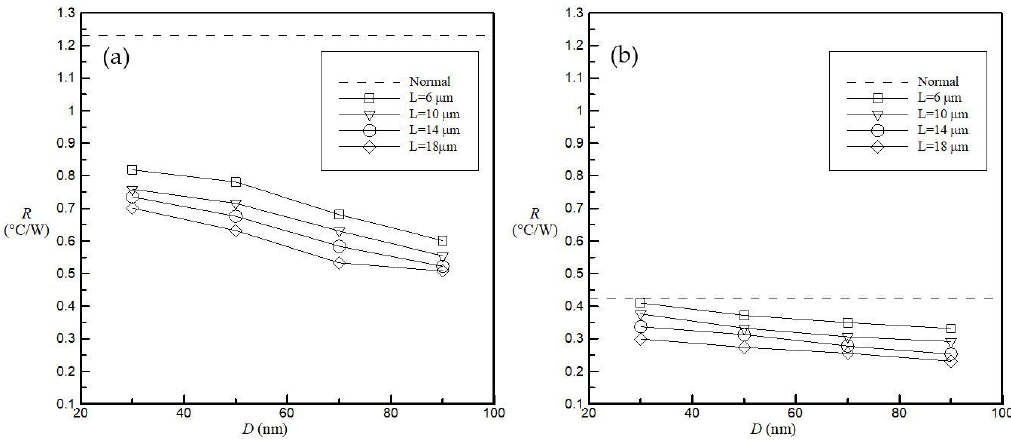
Figure 7. Variation of the overall thermal resistance R with the tube diameter D for different values of the tube length L with: ( a ) Q in = 25 W; and ( b ) Q in = 100 W.